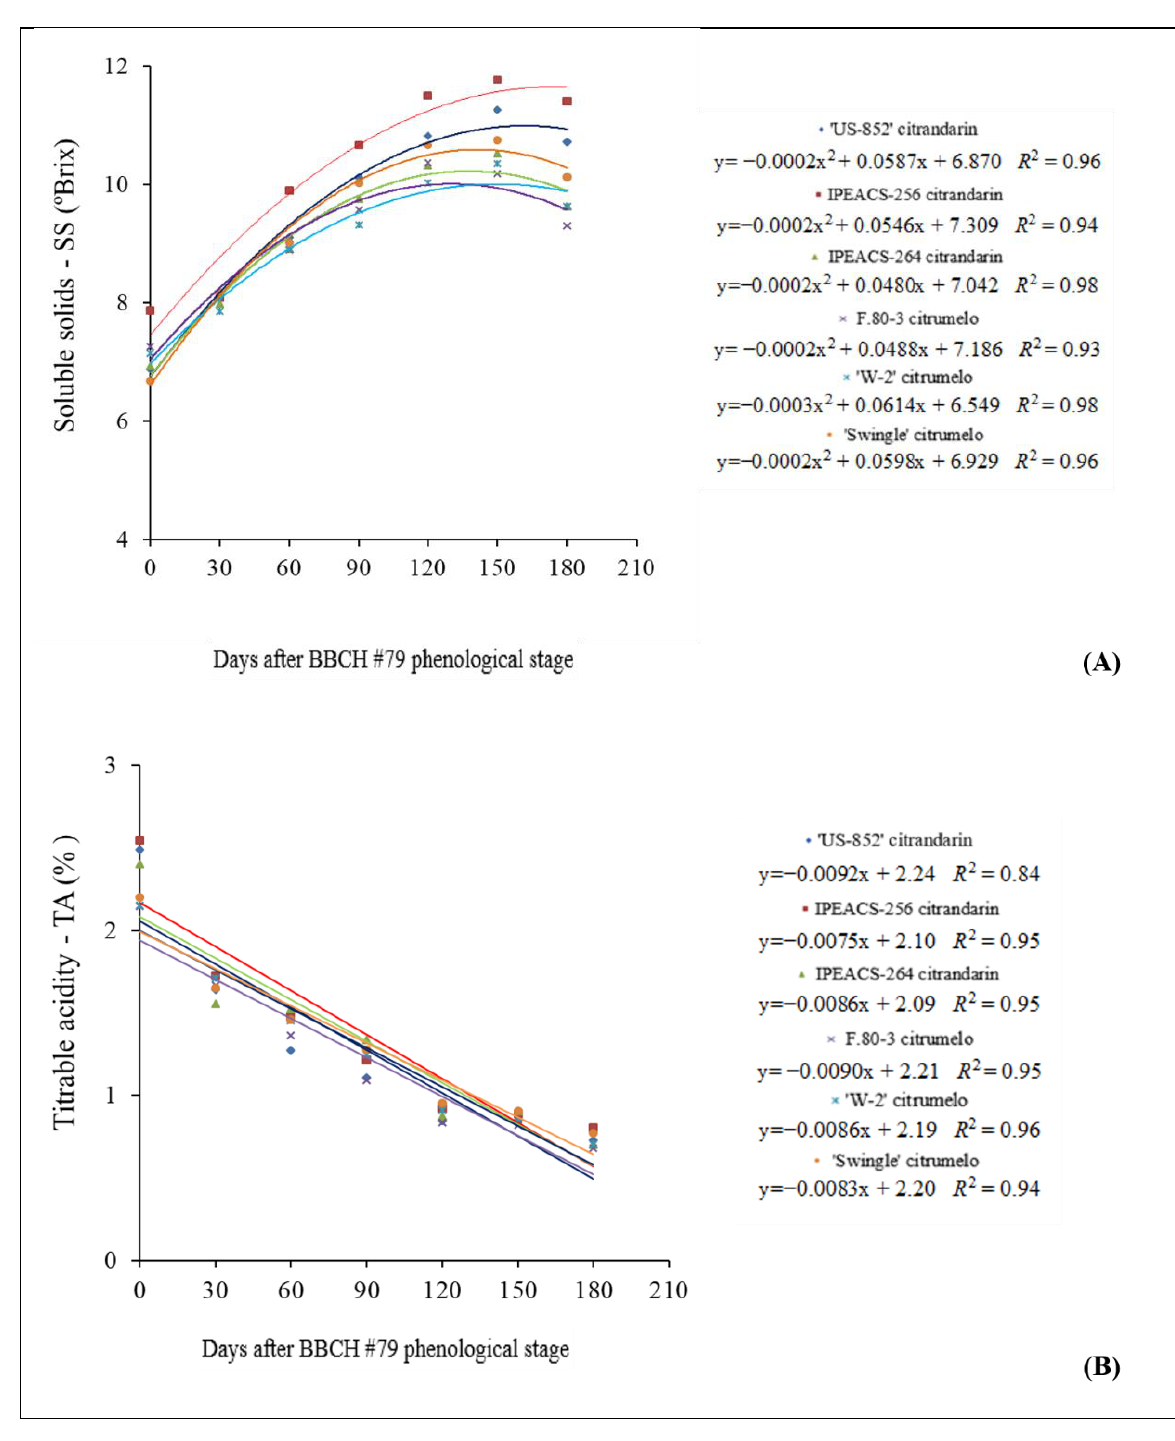
Figure 4. Development of ‘Valencia’ orange fruit ripening when trees are grafted on different ‘Trifoliata’ hybrid rootstocks at São Sebastião da Amoreira. ( A ): soluble solids (SS as ◦ Brix); ( B ): titratable acidity (TA as %). Phenological stage BBCH #79 (Meier, 2001), approximately to 200 days after flowering.